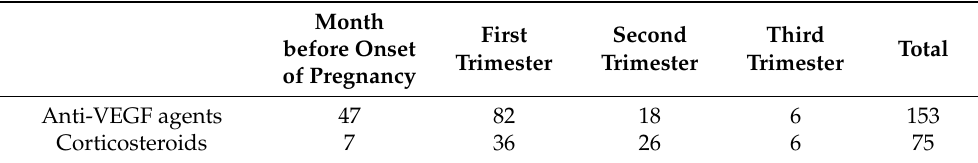
Month First Second Third Total before Onset Trimester Trimester Trimester of Pregnancy